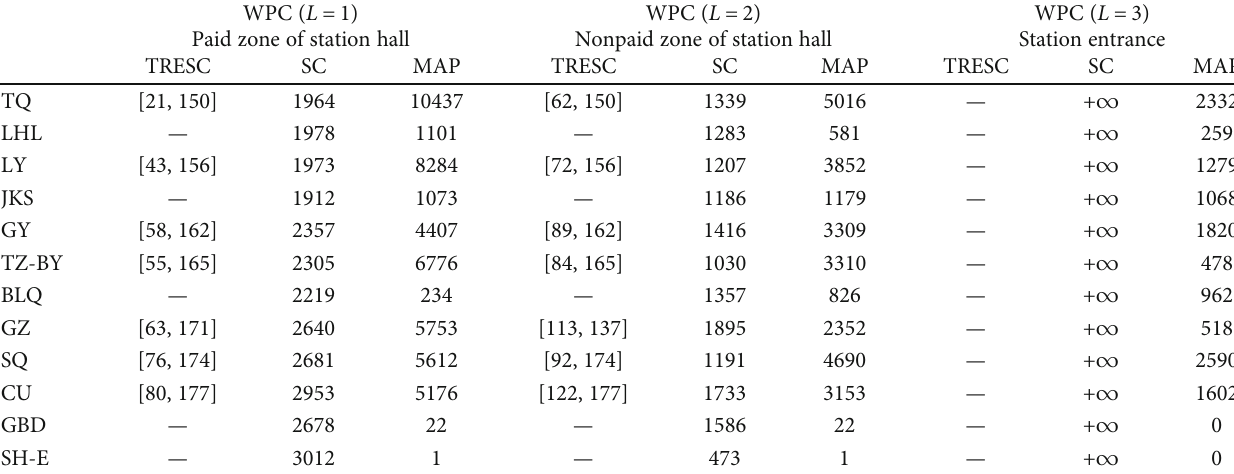
Figure 8: Accumulated passengers in the key area at CU station. Table 6: The time range for exceeding the safe capacity in the key area of all stations ( L = 3